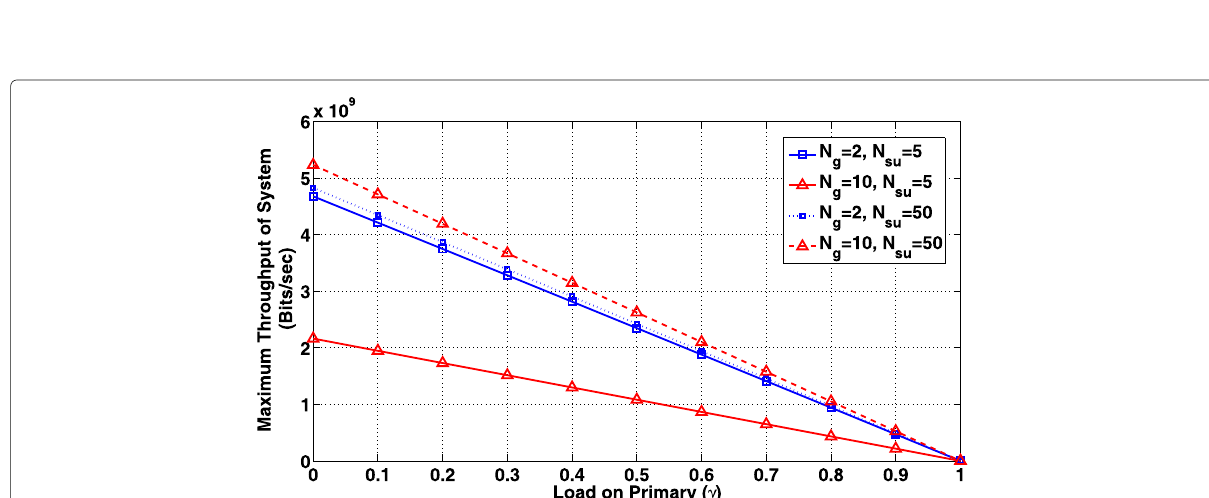
Fig. 12 Maximum throughput of the system in parallel sensing scheme versus primary traffic load when N g = 2 and 10 with N su = 5 and